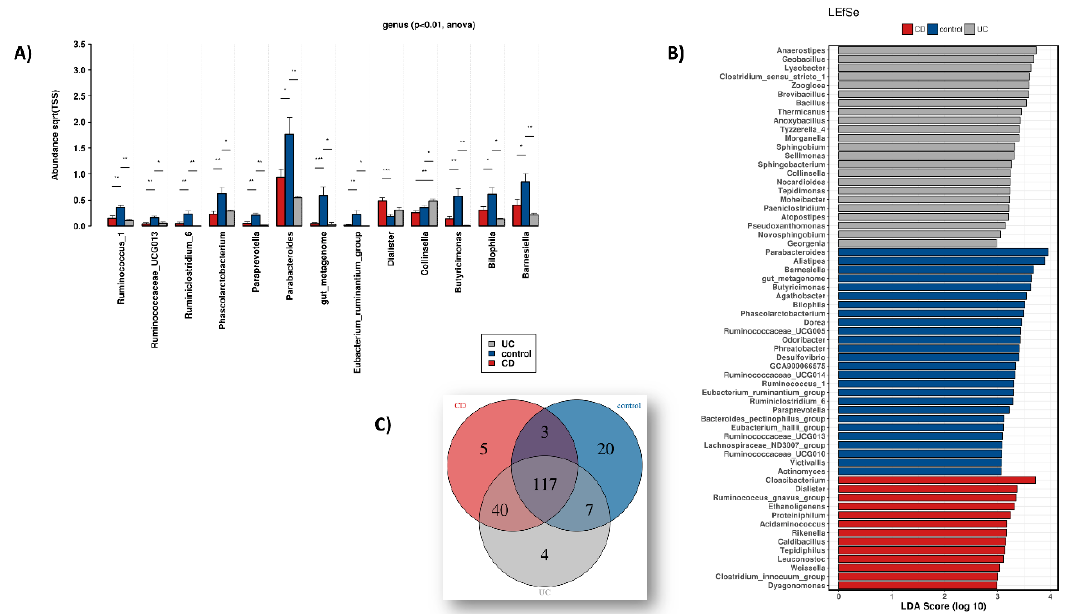
Figure 3. (A ) Relative abundance changes of the microbial genera among healthy controls (control), Crohn’s disease (CD) and ulcerative colitis (UC) patients. ( B ) LEfSe analysis showing microbial genera associated with the 3 groups. ( C ) Venn diagram depicting the microbial genera constantly present (core microbiome) in the samples of the 3 groups versus those found exclusively in HC, CD and UC.